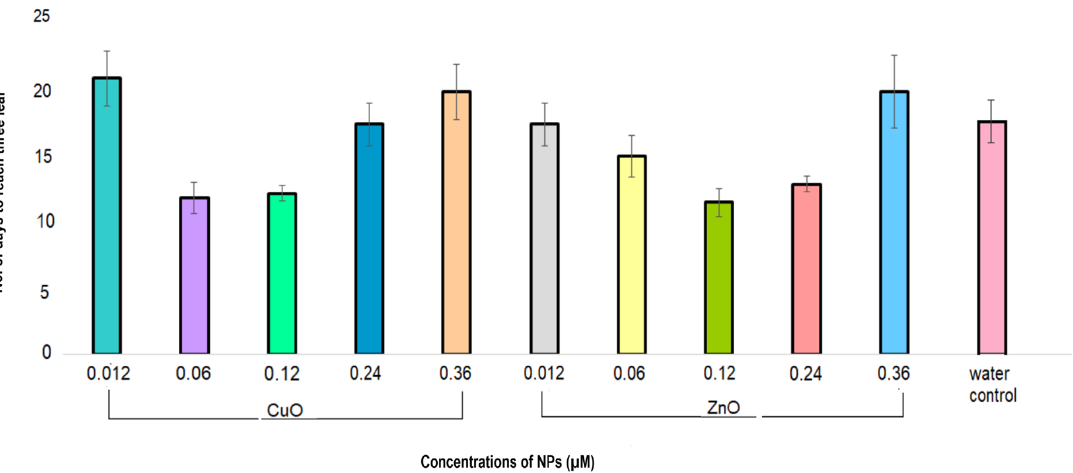
Figure 6. Effect of varying concentrations of CuO and ZnO nanoparticles on the development of Amaranthus hybridus seeds to reach the three-leaf stage. CuO and ZnO nanoparticles in the concentrations 0.012, 0.06, 0.12, 0.24, and 0.36 µ m were spiked in half-strength Hoagland’s medium. A water control and media controls were maintained. Bars represent the mean and standard error (SE) of three replicates (three seeds in each replicate). Significant differences between the means were calculated at p < 0.05.